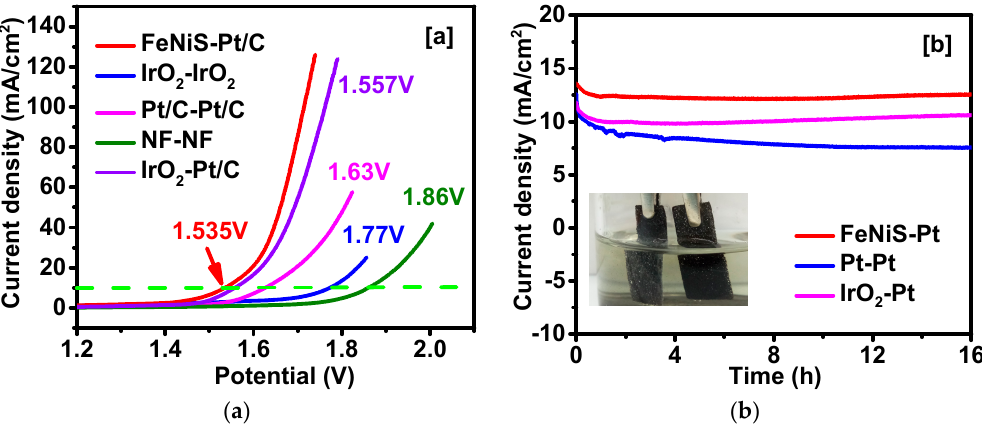
Figure 5. Results for overall water splitting using two electrode system: ( a ) polarization curves for FeNiS-Pt/C, IrO 2 -IrO 2 , Pt/C-Pt/C, NF-NF and IrO 2 - Pt/C and ( b ) chronoamperometry plots for FeNiS-Pt/C, Pt/C-Pt/C and IrO 2 -Pt/C.